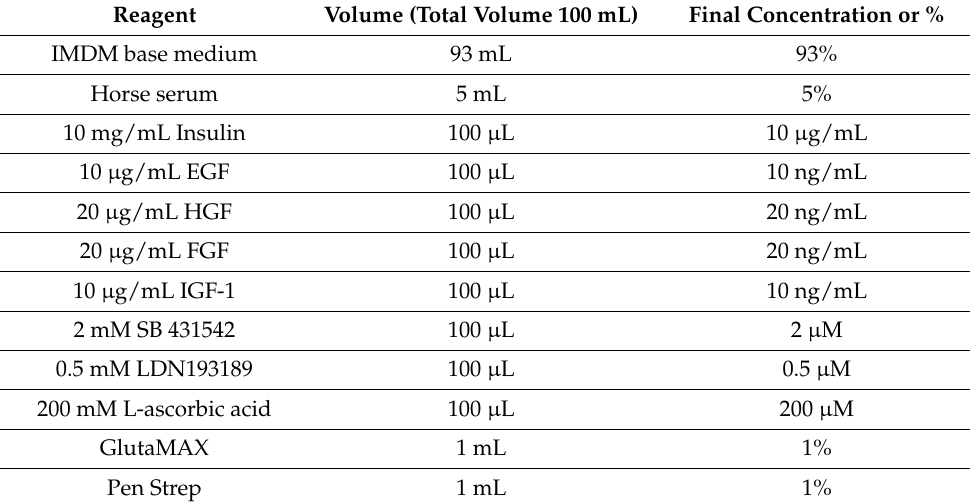
Table 5. Reagents needed to make 100 mL of